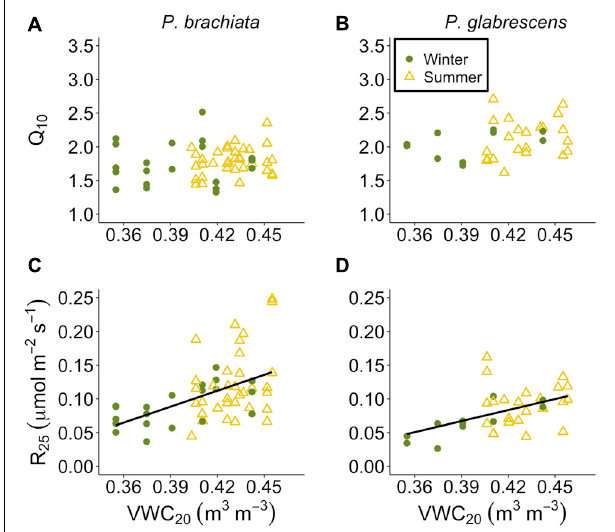
FIGURE 9 | Respiration parameter responses to soil moisture at 20–30 cm depth ( VWC 20 ). (A) Psychotria brachiata increase in respiration for every 10 ◦ C (Q 10 ) response to VWC 20 of winter (green circles) and summer (yellow triangles), (B) Piper glabrescens Q 10 response to VWC 20 (C) P. brachiata rate of respiration at 25 ◦ C ( R 25 ) response to VWC 20 , and (D) P. glabrescens R 25 response to VWC 20 . Fit lines (green - winter; yellow – summer) indicate a significant interaction between VWC 20 and season ( Supplementary Table S7 ). A solid black line is fit when there is a significant VWC 20 response but no interaction ( Supplementary Table S7